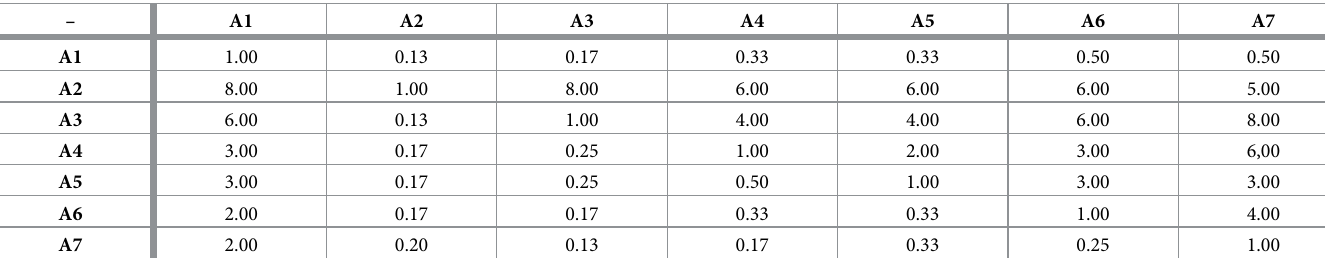
Table 2. Peer to peer evaluation